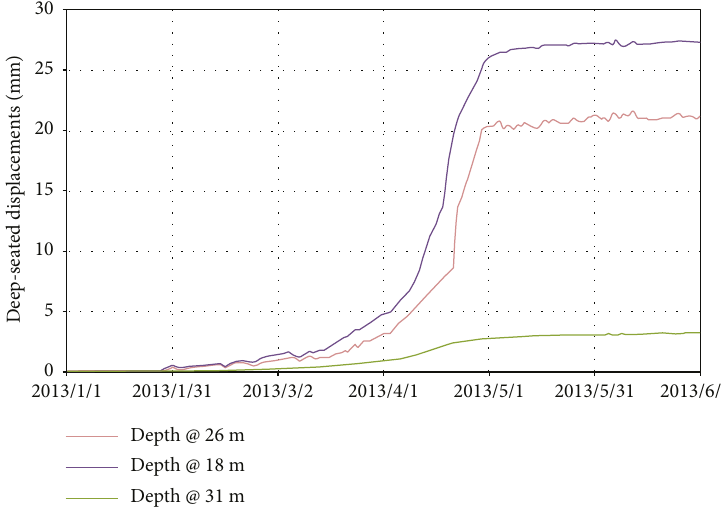
Figure 6: Reservoir water level versus deep-seated resultant displacement